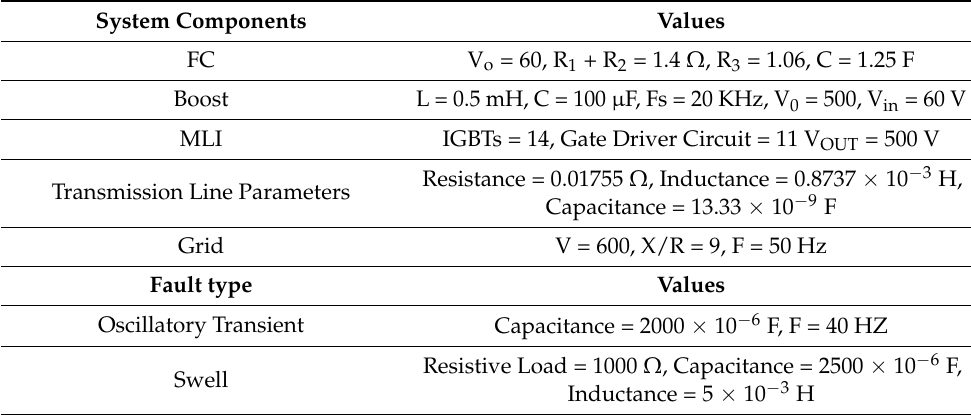
Table A1. System component